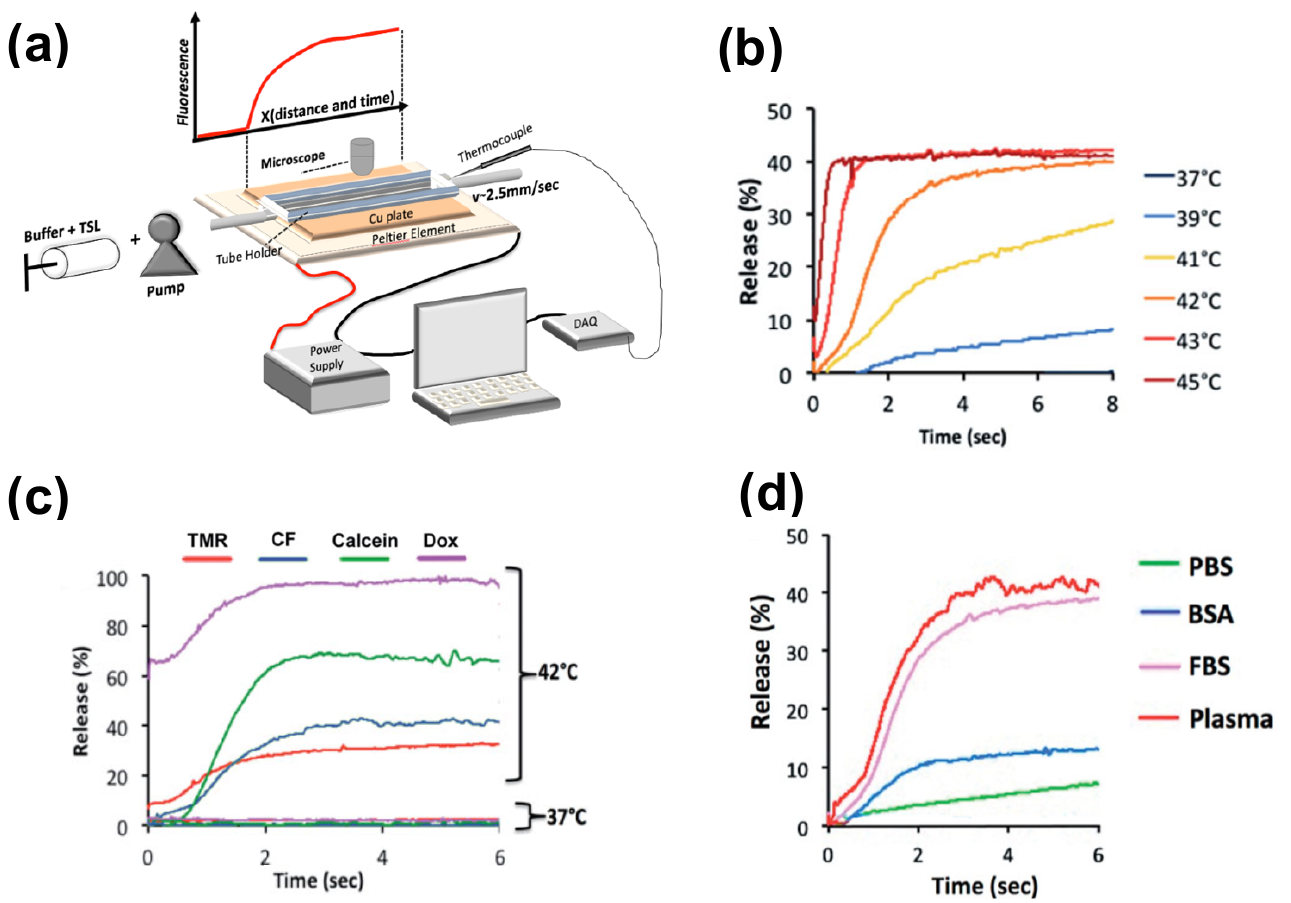
Figure 6. Measuring release kinetics of fast-release TSL formulations. ( a ) Millifluidic release assay schematics. A TSL solution (TSL + buffer) is pumped through a capillary tube that has been heated